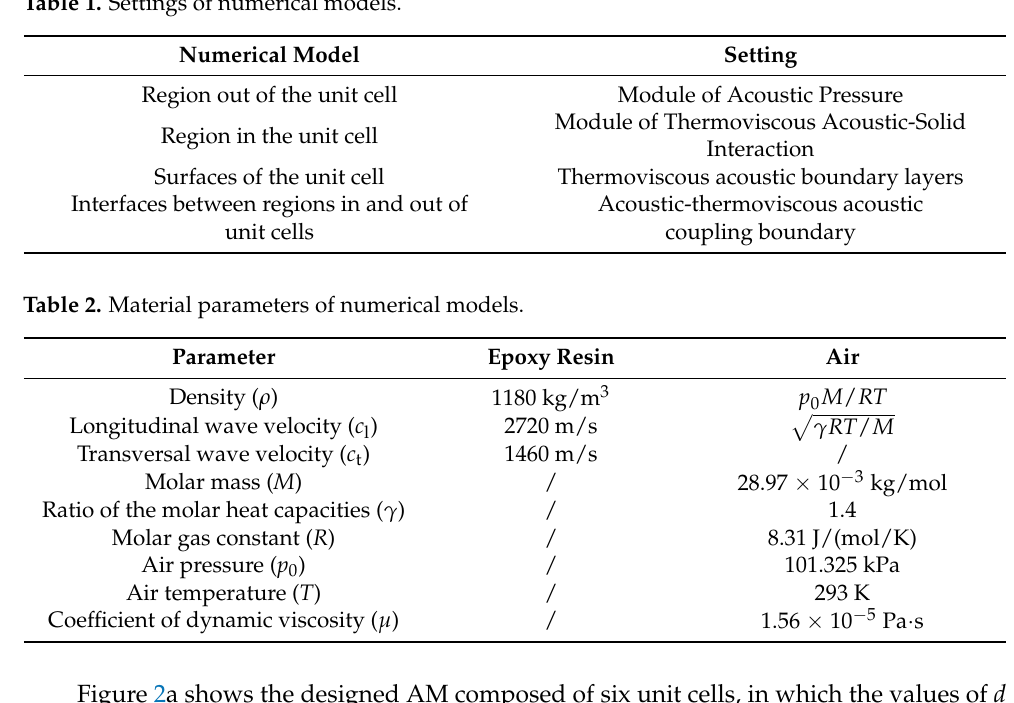
Figure 1. ( a ) Schematic of a low-frequency ultrathin unit cell with a coiling space structure. ( b ) Phase delays of a normally incident wave created by the unit cell as a function of parameter d at 370 Hz. Six red open circles represent the selected units, with d = 6.0 mm, 9.4 mm, 11.7 mm, 13.4 mm, 14.8 mm and 16.1 mm from left to right. Table 1. Settings of numerical models.